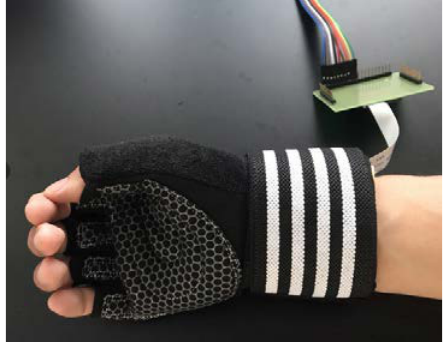
Figure 9. The wearable pulse wave monitoring system.